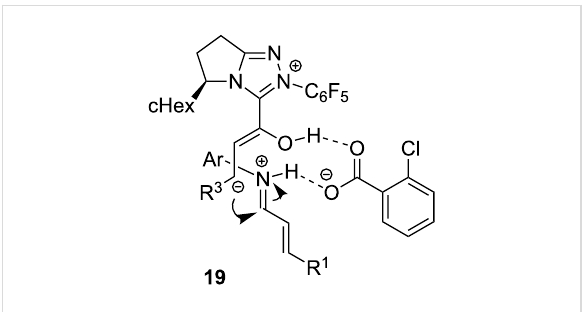
Figure 1: Proposed hydrogen-bonding intermediates 19 in the forma- tion of pyrrolidin-2-ones 16 .